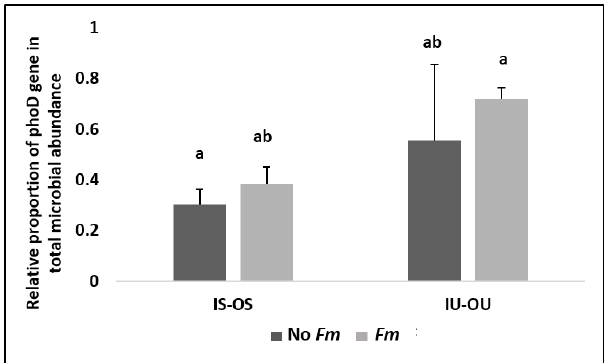
Figure 4. Relative proportion of phoD gene among the total microbial community abundances (as total 16S rRNA and ITS) in hyphosphere soil. 1 = 100%. IS-OS: soil in inner (hyphosphere) and outer (rhizosphere) compartments sterilized; IU-OU: both soils unsterilized. “ Fm ”: inoculated with Funneliformis mosseae . Data presented are mean with ± standard deviation ( n = 3). Di ff erent letters above the bars indicate significant di ff erence between the treatments ( p <